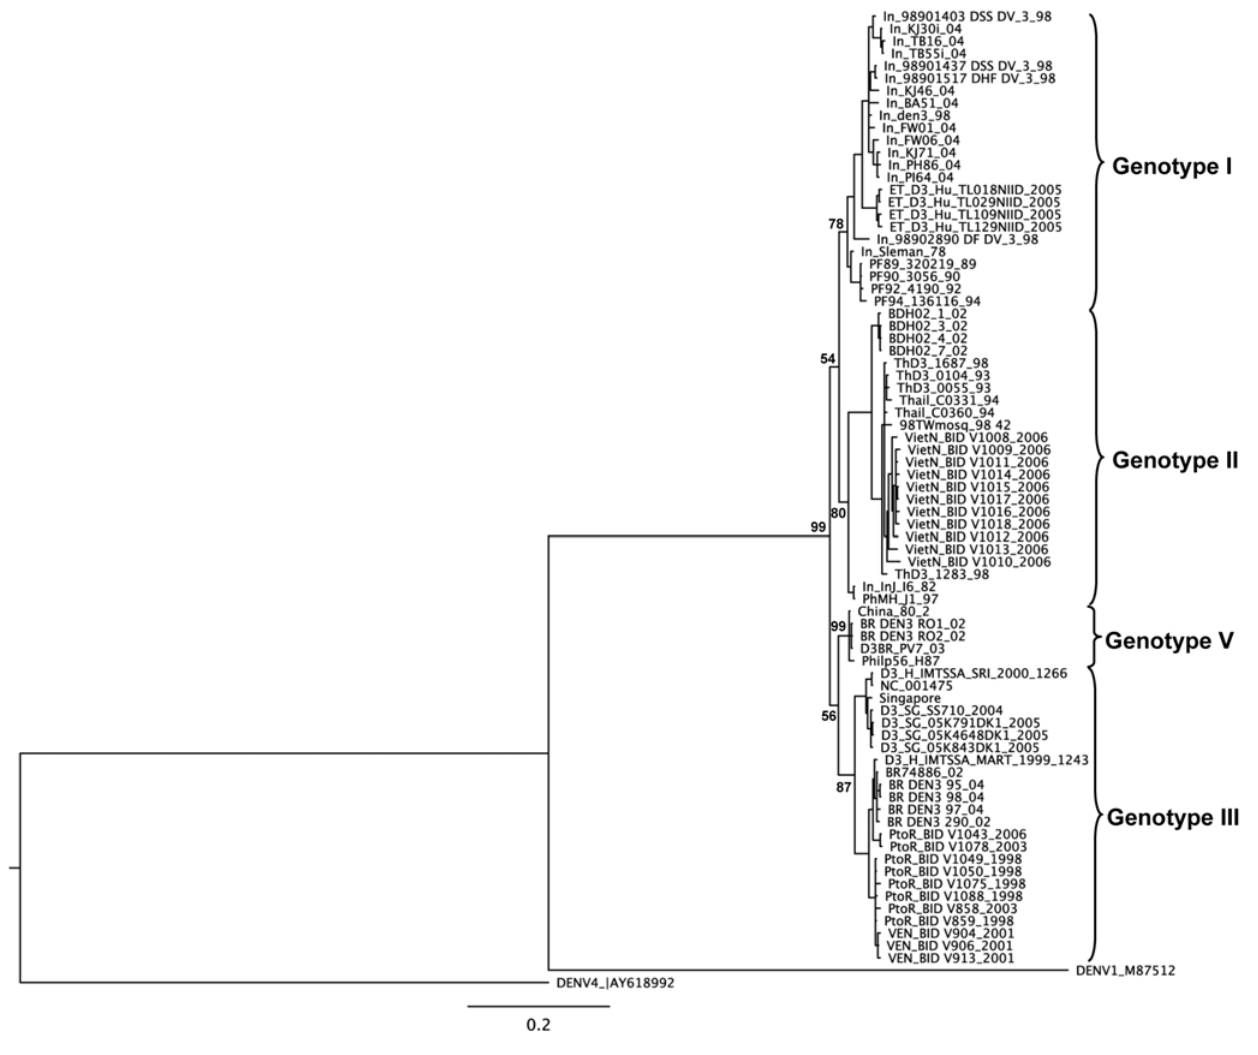
Figure 3. Bayesian phylogenetic trees derived from 79 global samples of DENV-3 NS1 gene sequences inferred with MrBayes program. The posterior probabilities expressed in percent are indicated at important nodes. DENV-1 (M87512) and DENV-4 (AY618992) strains were used as outgroup. Horizontal branch lengths are drawn to scale. Aligned sequences were analyzed in the MrModeltest 2.3 program to identify the best fit-model of nucleotide substitution for Bayesian phylogenetic reconstruction. The nucleotide substitution model used was under a General Time Reversible model of nucleotide substitution with gamma-distributed rate variation (G=1.9241) and a proportion of invariable sites (I=0.4401) (GTR + G + I), using Akaike’s Information Criterion (AIC). Five runs of 4 chains each (one cold and tree heated, temperature=0.20) were run for 1.5 6 10 6 generations, with a burn-in of 6000 generations. GenBank accession numbers: D3BR PV7 03 (FJ481174), In_98901403_DSS_DV_3_98 (AB189125), In_98901437_DSS_DV_3_98 (AB189126), In_98901517_DHF_DV_3_98 (AB189127), In_98902890_DF_DV_3_98 (AB189128),